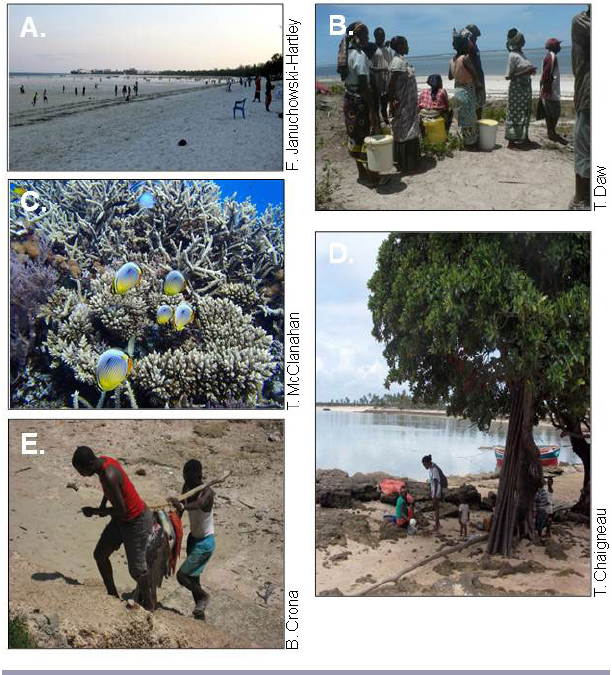
Fig. 3 . Images representing the five ecosystem services in Table 2. (A) The wave attenuation provided by the coral reef offshore at Bamburi beach, Mombasa, provides calm waters and beachfront for recreation in the evenings. (B) Female fish traders buying fish from fishers in Kenya. (C) Colorful corals and associated fishes of high value in international aquaria trade. (D) People resting in the shade of a tree in Vamizi, Mozambique. (E) Fishermen bringing large reef fish